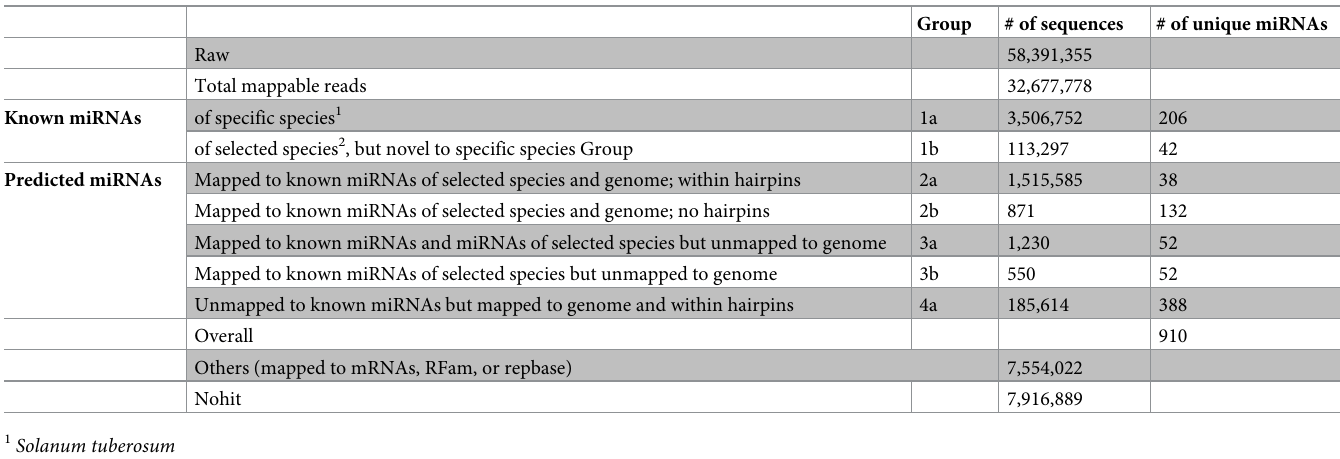
Table 1. Summary of data analysis results. Raw